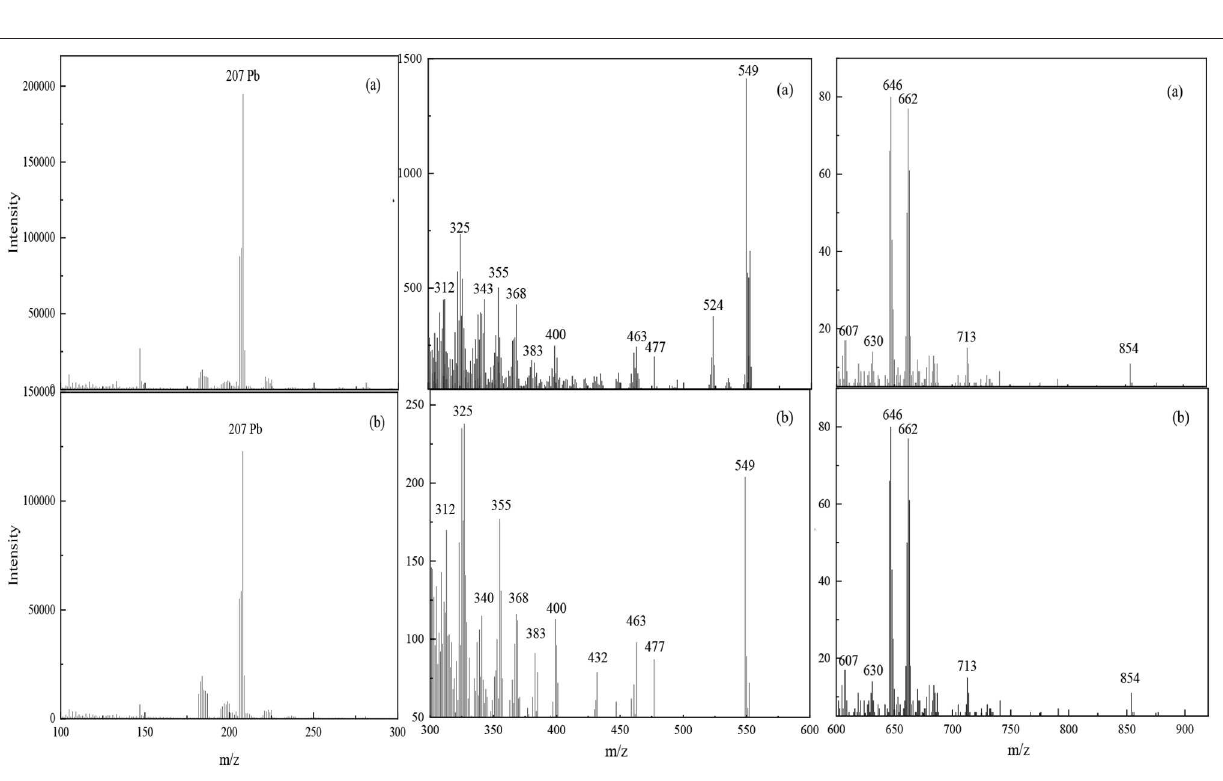
N-O (or C = N) bonds, whereas more N-O (or C = N) and N-Pb bonds appeared when the scheelite surface was treated with Pb-BHA complexes. This indicated that complexes adsorbed on the scheelite surface had different contents of the various structural components. Overall, according to the XPS results, the components of complexes adsorbed on the scheelite surface